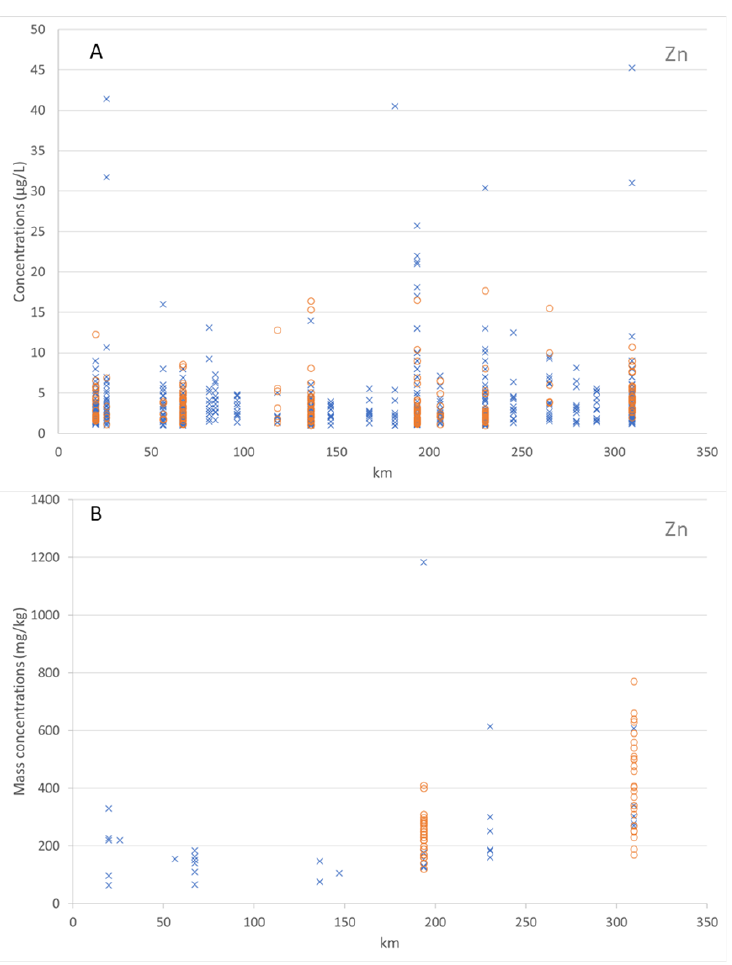
Figure 7. ( A ) Dissolved zinc concentrations (blue crosses, µg/L, years 2012 to 2019) and total zinc concentrations (orange circles, µg/L, years 2017 to 2019) in the water column along the Mosel river (from the source to the French border, in km), and ( B ) adsorbed zinc mass concentrations on the bed sediment (blue crosses, mg/kg, particles < 2 mm) and adsorbed zinc mass concentrations on the suspended sediment in the water column (orange circles, mg/kg, particles < 2 mm) along the Mosel river (from the source to the French border, in km), from the year 2012 to 2017. The zinc concentrations were higher than the copper concentrations in the water col- umn and on the sediments. The data analyses demonstrated that both Cu and Zn were more adsorbed by the suspended sediment than the bed sediment, due to the higher pro- portion of fine particles in the suspended sediment (coarser particles settling first).